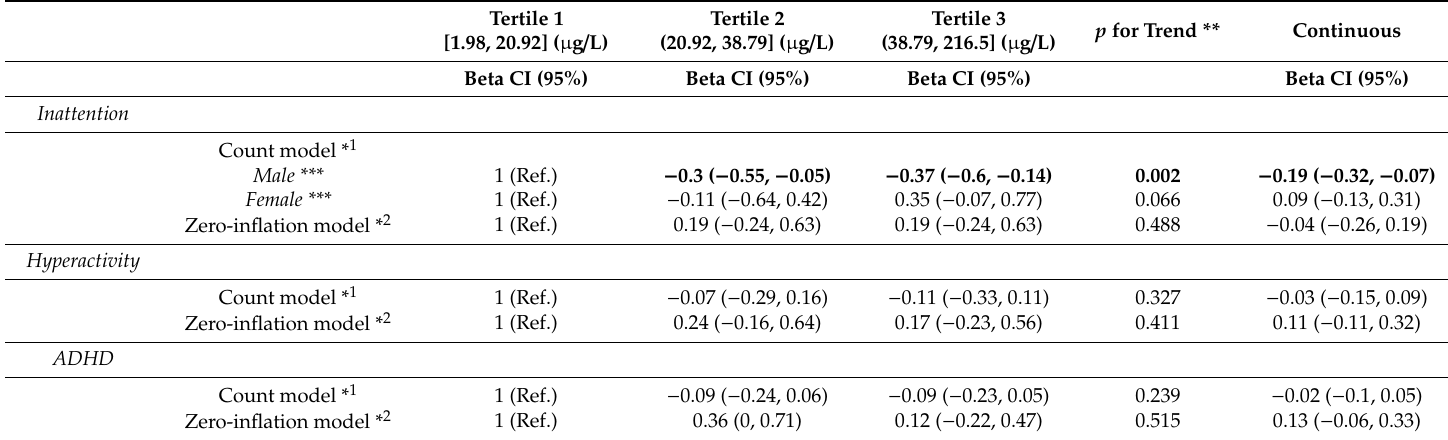
Table 3. Zero-inflated Poisson regression models for the association between inattention, hyperactivity and ADHD symptoms with ferritin levels ( µ g / L log scale) in continuous scale and in